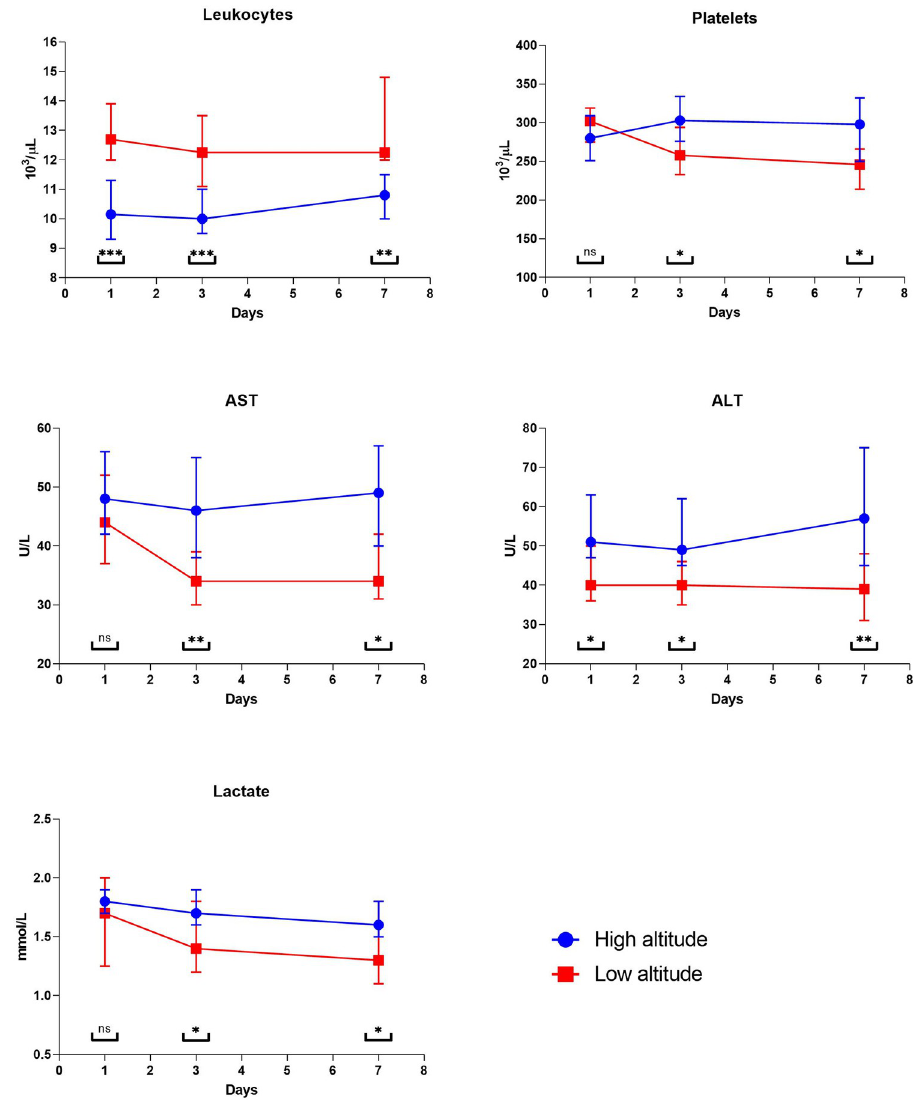
Fig 1. Statistical hematological differences between the low and high-altitude group. All comparisons were calculated using a U Mann-Whitney test � = < 0.05; �� = < 0.01; ��� = < 0.001; ns = non-significant. Abbreviations: ALT: Alanine aminotransferase; AST: Aspartate